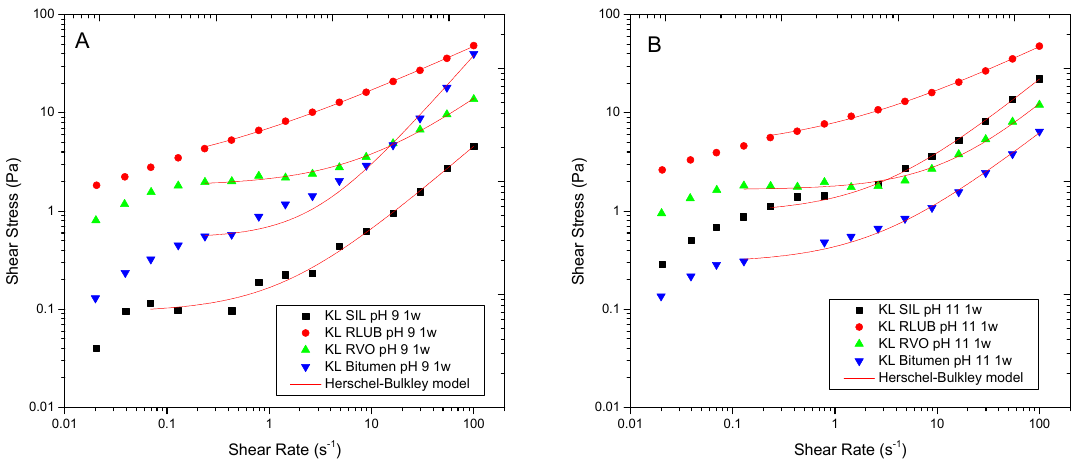
Figure 8. Effect of emulsification pH on the flow behaviour of bitumen emulsions stabilized by Kraft lignin after 1 week storage at pH 9 ( A ) and 11 ( B ).